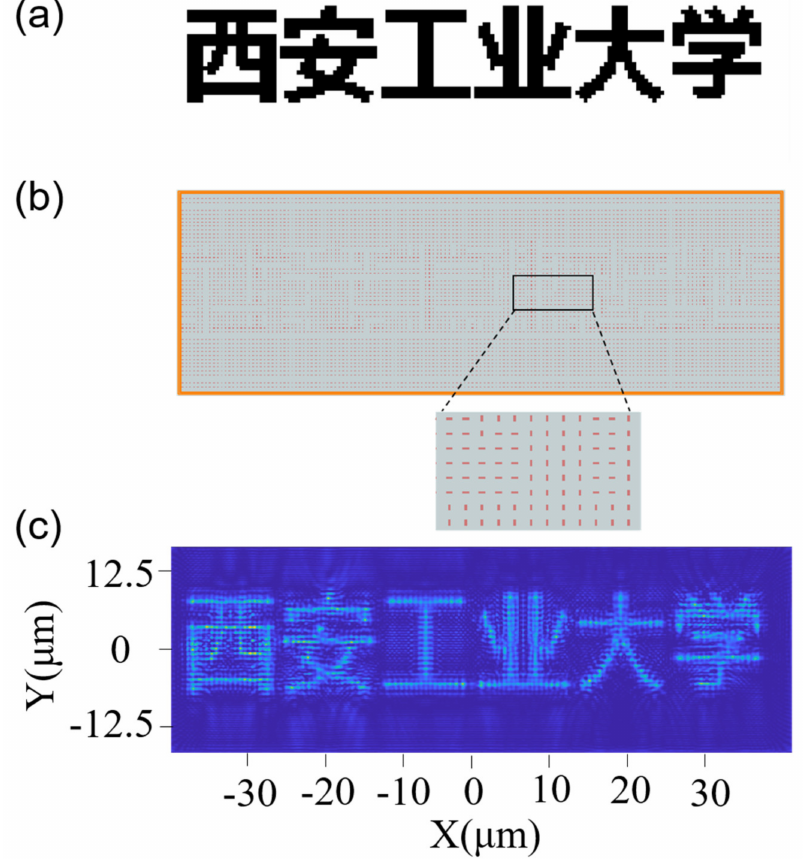
Figure 6. ( a ) A binary grayscale image. ( b ) The arrangement of the nano‑Polarizer array. ( c ) The near‑field light intensity distribution of the output